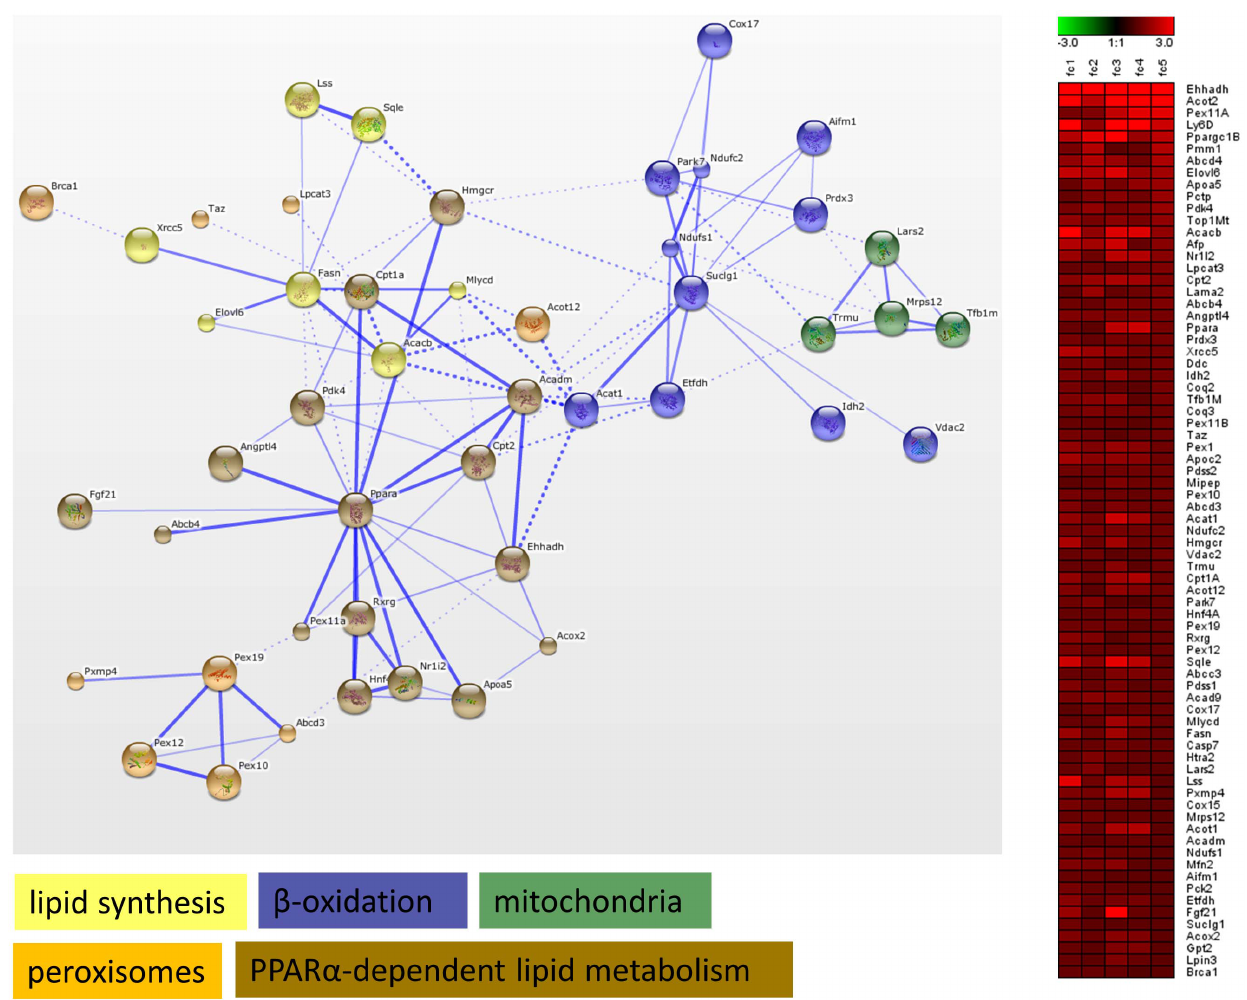
Figure 3. Functional clustering of genes involved in energy metabolism (amiodarone). Genes related to energy metabolism identified by GSEA as being significantly altered upon amiodarone (AMI) treatment were subjected to functional clustering in STRING. Functional clusters such as lipid synthesis, b -oxidation, mitochondria, peroxisomes, and PPAR a -dependent lipid metabolism were identified. Information about fold change (FC=treatment vs. control) for the analysed genes in individual mice is presented as a heat map. Genes that did not form connected nodes were removed from the presented clusters. Thicker lines represent stronger associations between genes. Inter-cluster edges are represented by dashed- lines. The bigger spheres represent genes coding for proteins with known structure. Smaller spheres represent genes coding proteins for which no structural information is available. portion was mixed with 100 m L of ATP lytic buffer from ATPlite kit (Perkin Elmer, Oosterhout, The Netherlands) for ATP measurement, which was carried out with a microplate reader Synergy TM HT Multi Detection Microplate Reader (Biotek Instruments Inc, Abcoude, the Netherlands) with settings for luminescence: 590/635 nm, top measurement, and sensitivity 230. ATP was determined in technical duplicates and luminescence values were recalculated as m M ATP in total liver slice extracts. protein assay (BioRad, Veenendaal, The Netherlands). Protein samples of 2 m L were diluted 80 times in PBS and measured, with BSA used as a standard, each measurement being taken in duplicate. ATP concentration was normalized to mg of protein per slice.